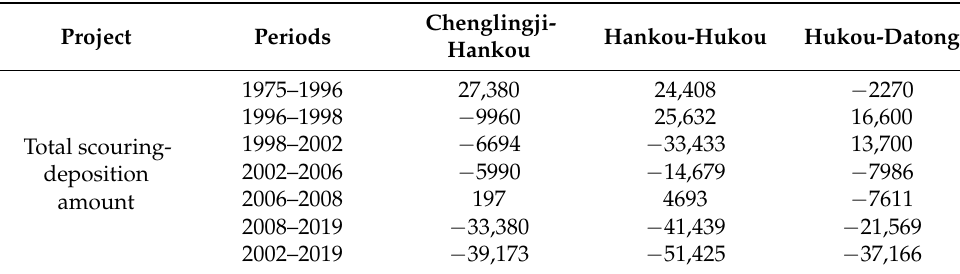
Table 6. Comparison of erosion–deposition amount from Chenglingji to Datong in the middle reaches of the Yangtze River in different periods (10 4 m 3 ).